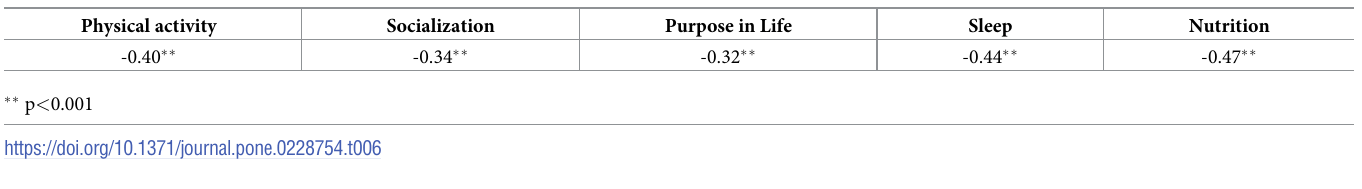
Table 6. Linear regressions between habit changes and baseline scores. Number in table are standardized beta